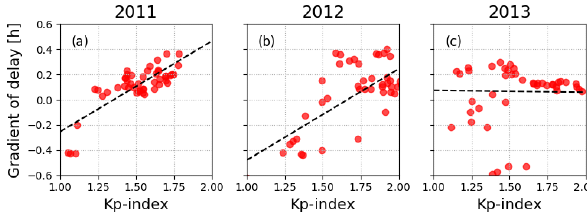
Figure 6. The scatter plots for 2011 (a) , 2012 (b) , and 2013 (c) show the correlation between the Kp index and gradient of the delay. The smoothed weekly means (running mean with window size of 10d) are used for this comparison. Correlation coefficients of ≈ 0 . 80 (a) , ≈ 0 . 73 (b) , and ≈ − 0 . 01 (c) are estimated. All data correspond to the location of Canberra at 35.3 ◦ S and 149.0 ◦